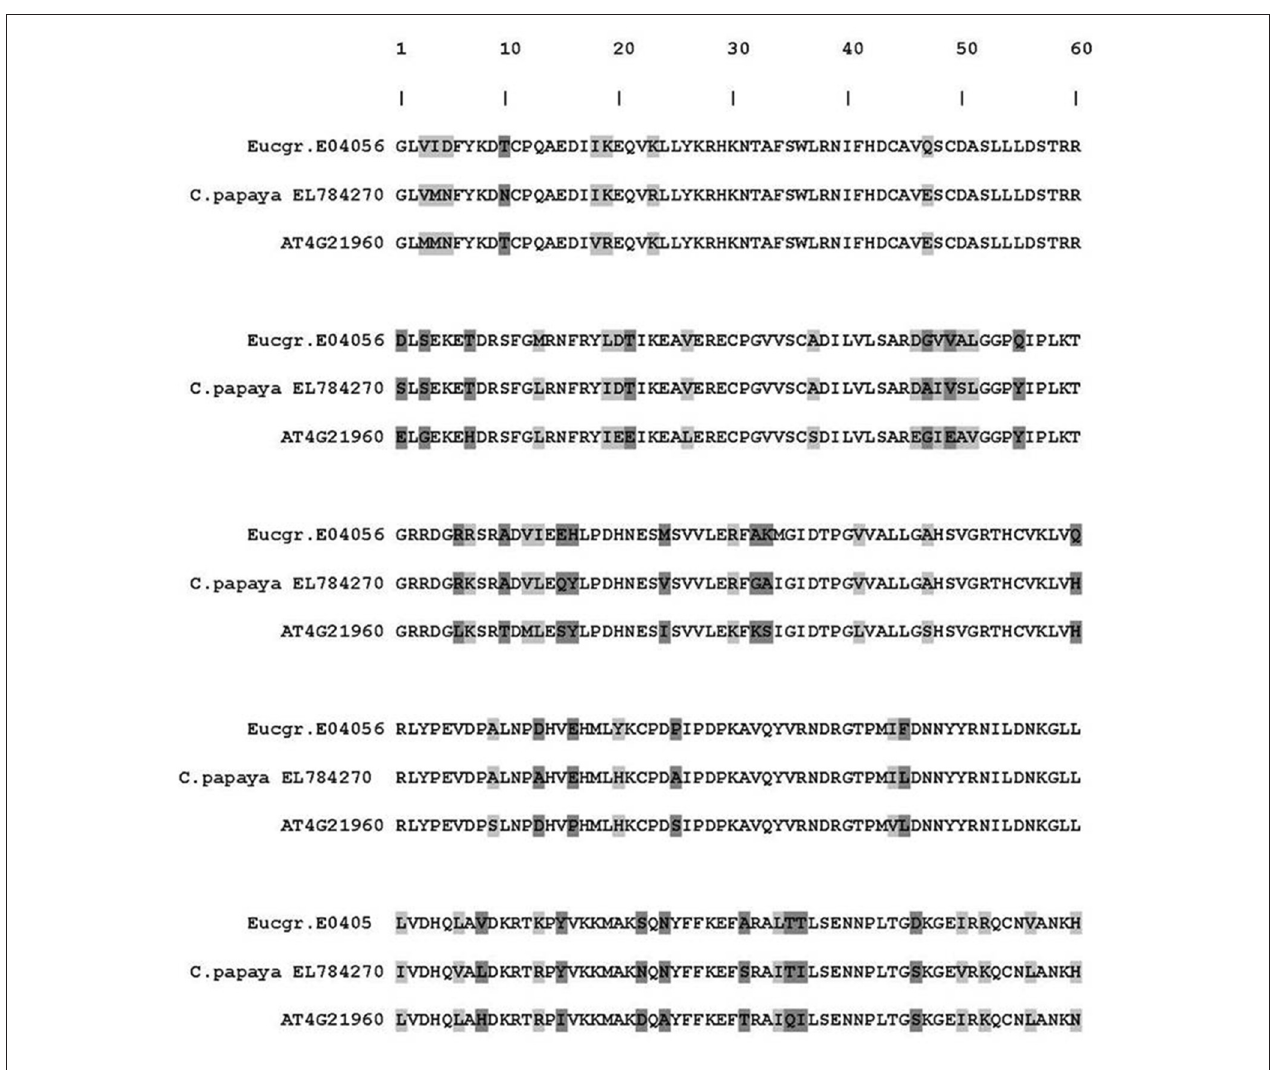
FIGURE 6 | Amino acid alignment of the putative PR-9 peroxidase ortholog of Eucalyptus nitens (Phytozome: Eucgr.E04056) in comparison to the Arabidopsis thaliana (TAIR number AT4G21960) and Carica papaya (Genbank: EL784270) orthologs. Light gray highlights conservative amino acid substitutions and dark gray indicates non-conservative